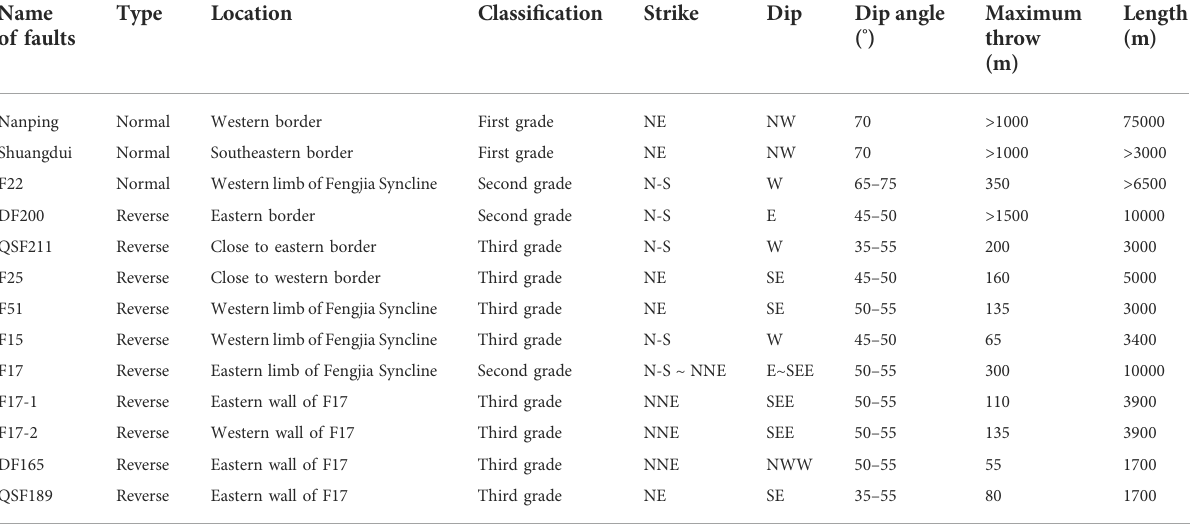
TABLE 1 Statistics of major fault characteristics in the Qianyingzi Coal Mine. Name of